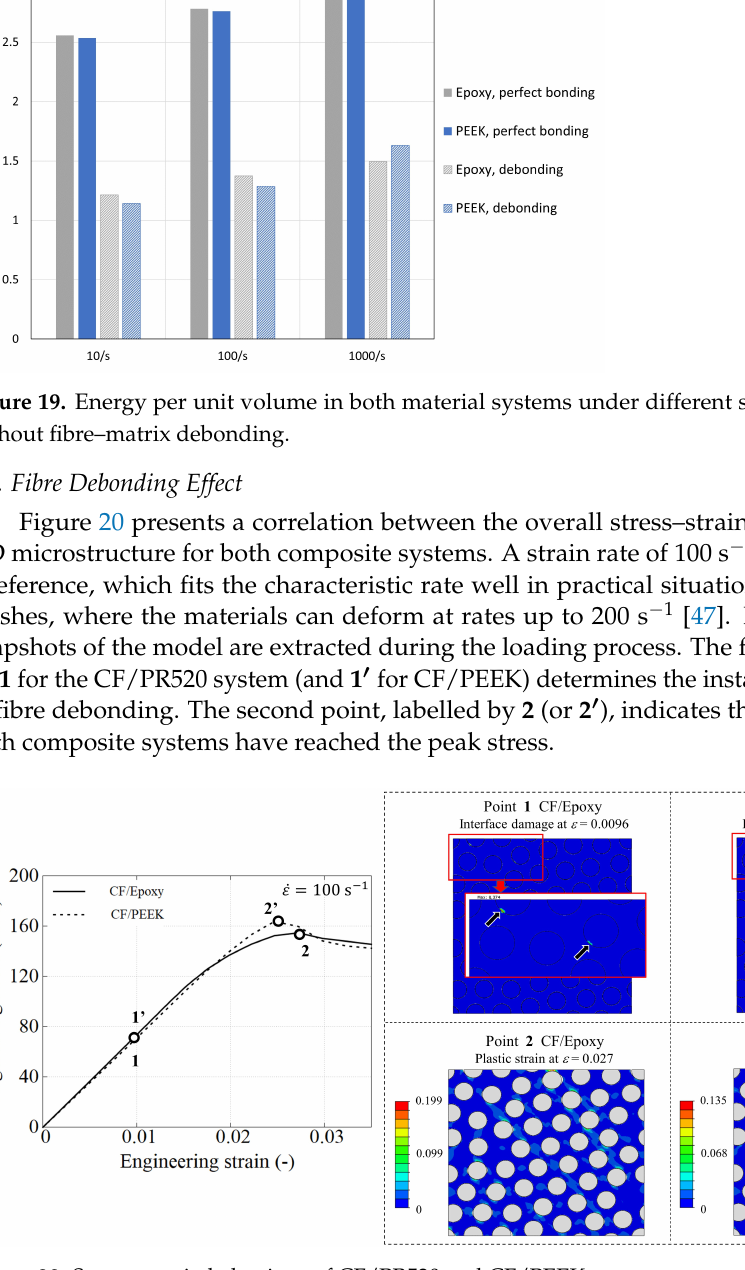
Figure 20. Stress − strain behaviour of CF/PR520 and CF/PEEK systems at two representative points: onset of debonding and at peak